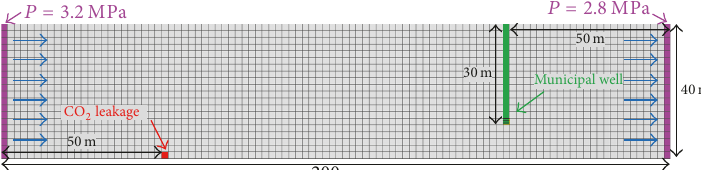
Figure 3: Conceptual model representing the shallow potable aquifer with a length and thickness of 200 m and 40 m, respectively. Blue arrows represent ambient groundwater flow with the rate of 2cm/day. The grid blocks with the purple color stand for constant pressure boundaries; left and right boundary are 3.2 MPa and 2.8 MPa, respectively. Both upper and lower boundaries are assumed to be the no-flow boundary. CO 2 leakage point (red) is located at 50 m away from the left boundary. In addition, the municipal well (green) located at 50 m away from the right boundary penetrates 30 m deep from the upper seal while the pumping activity was only conducted through the screened